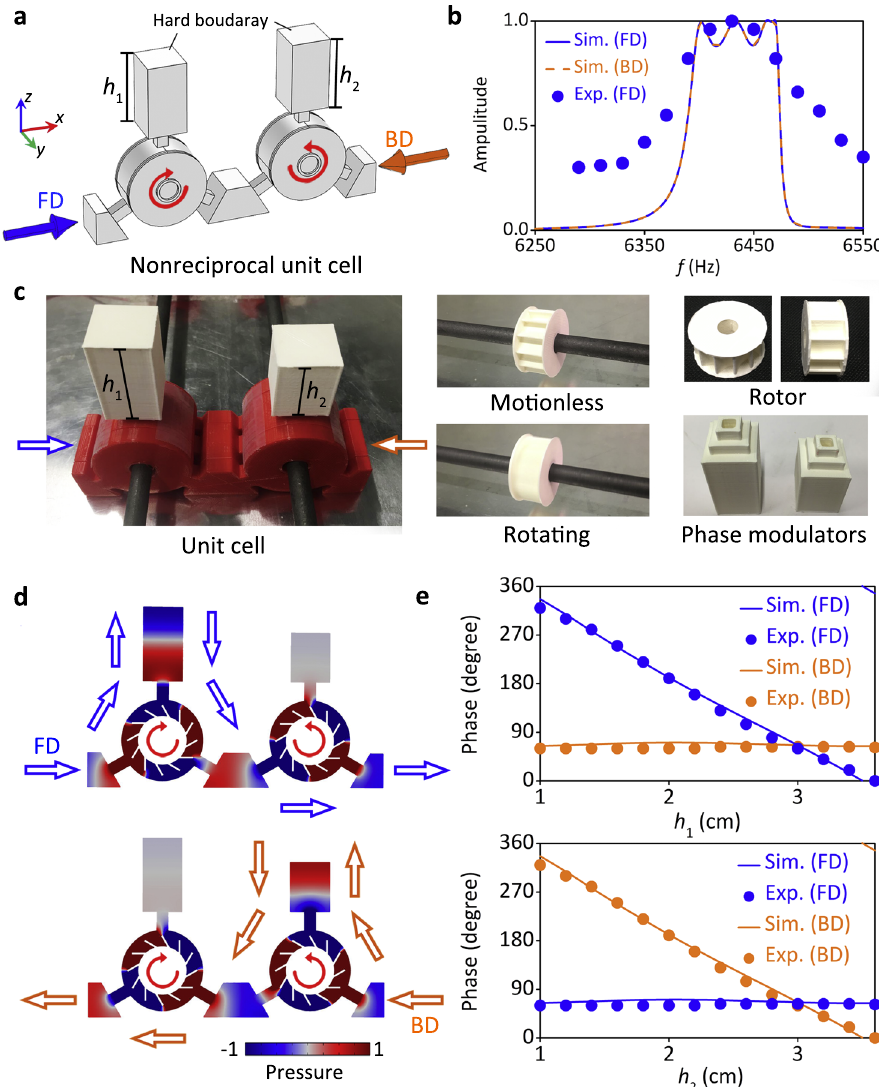
Fig. 3 Design of nonreciprocal unit cell. a The nonreciprocal unit cell consists of two circulators with opposite rotating inner cores, viz ., n = − n = 720rpm, as marked by the red circular arrows. b The simulated and experimental ( n 1 2 direction) and BD (backward direction) incidences for the unit cell with h 1 = h 2 = 3 cm. c Photograph of the unit cell sample, it consists of 3D printed rotors (white), cavities (red), and recon fi gurable phase modulators (white). The blue and orange arrows indicate the FD and BD, respectively. The rotors are nested on carbon rods, which are driven by motors. d The acoustic pressure fi eld distributions in the resonators at 6430 Hz for FD and BD incidences, respectively. The arrows indicate the sound propagating paths. e The simulated (Sim.) and experimental (Exp.) phase responses at 6430 Hz for FD and BD, by independently changing the parameters of h 1 and h 2 ,